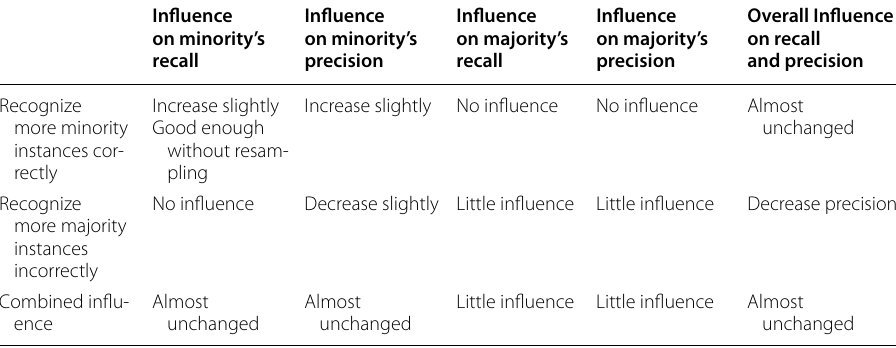
Table 49 Summary for recognizing minority and majority instances in not highly imbalanced datasets